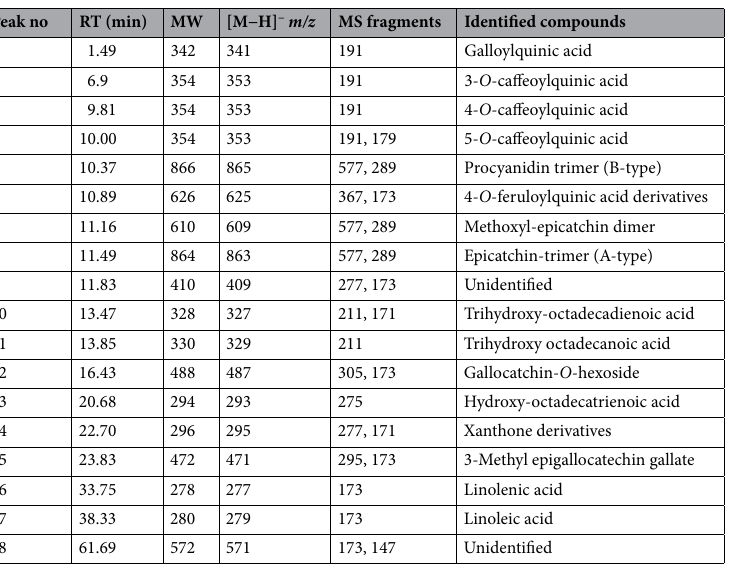
Table 6. Tentative identification of chemical constituents of F. auriculata fruit by LC-ESI